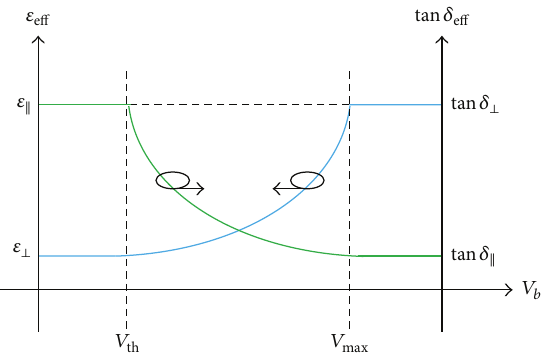
Figure 3: Effective relative permittivity of perpendicular ( 𝜀 ⊥ ) and parallel ( 𝜀 ‖ ) states and loss tangent (tan 𝛿 ⊥ and tan 𝛿 ‖ ) as function of the applied bias voltage ( 𝑉 𝑏